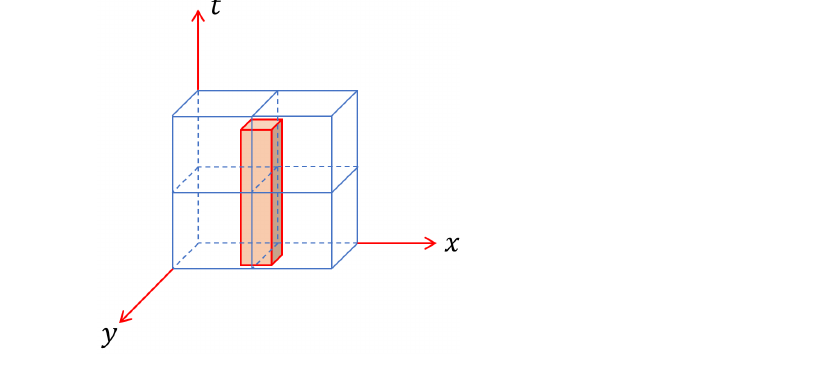
Figure 13. Schematic diagram of GeoSOT-ST under unbalanced spatial and temporal scales. Different Spatial Windows. Figure 12b presents the query time with different spatial windows for the real dataset. It is observed that (1) with a larger spatial window, most return more data; (2) as the scope of the query space increases, the performance of Z3